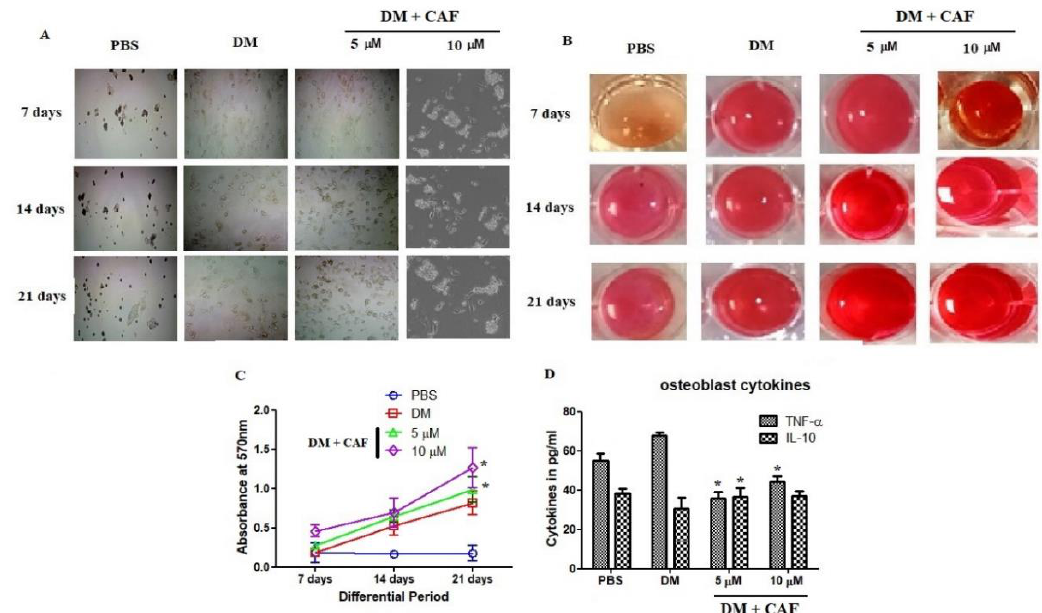
Figure 3. The di ff erentiation and in vitro mineralization of osteoblast was evaluated at CAF treated conditions. ( A ) Representative macroscopic ( B ) Microscopic observation of alizarin red S (ARS) ( C ) ARS quantification for osteoblastic Di ff erentiation at CAF treated conditions. ( D ) Cytokines estimation at 7th day of CAF treated osteoblastic cells. TNF- α and IL-10 were estimation using ELISA kits. Bars represent the mean ± SD ( n = 4). Statistical results are shown as * p < 0.05. Values compared between the PBS group with CAF at di ff erent concentrations.